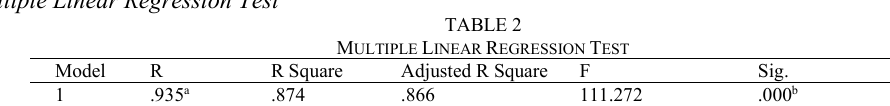
TABLE 2 M ULTIPLE L INEAR R EGRESSION T